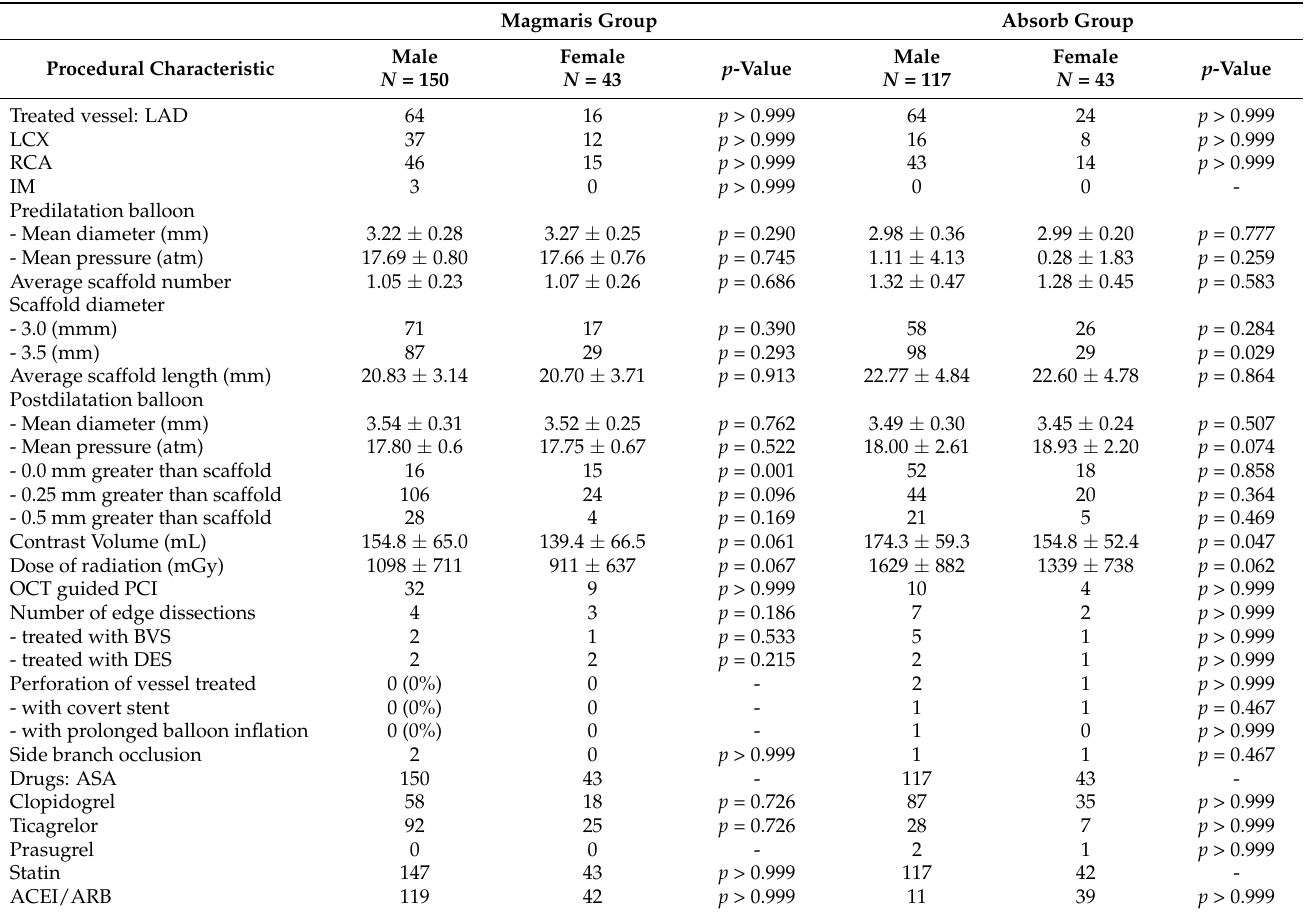
Table 2. Procedural characteristics of both study